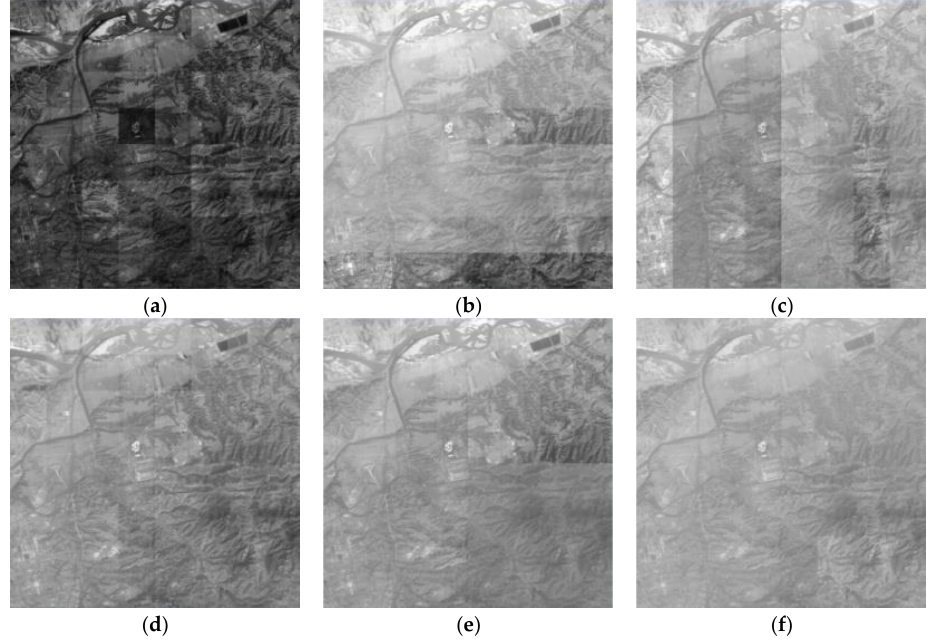
Figure 7. Results of different methods: ( a ) original image; ( b ) result based on left image benchmark; ( c ) result based on above image benchmark; ( d ) result based on left image cross; ( e ) result based on quadtree; and ( f ) result based on the proposed method.